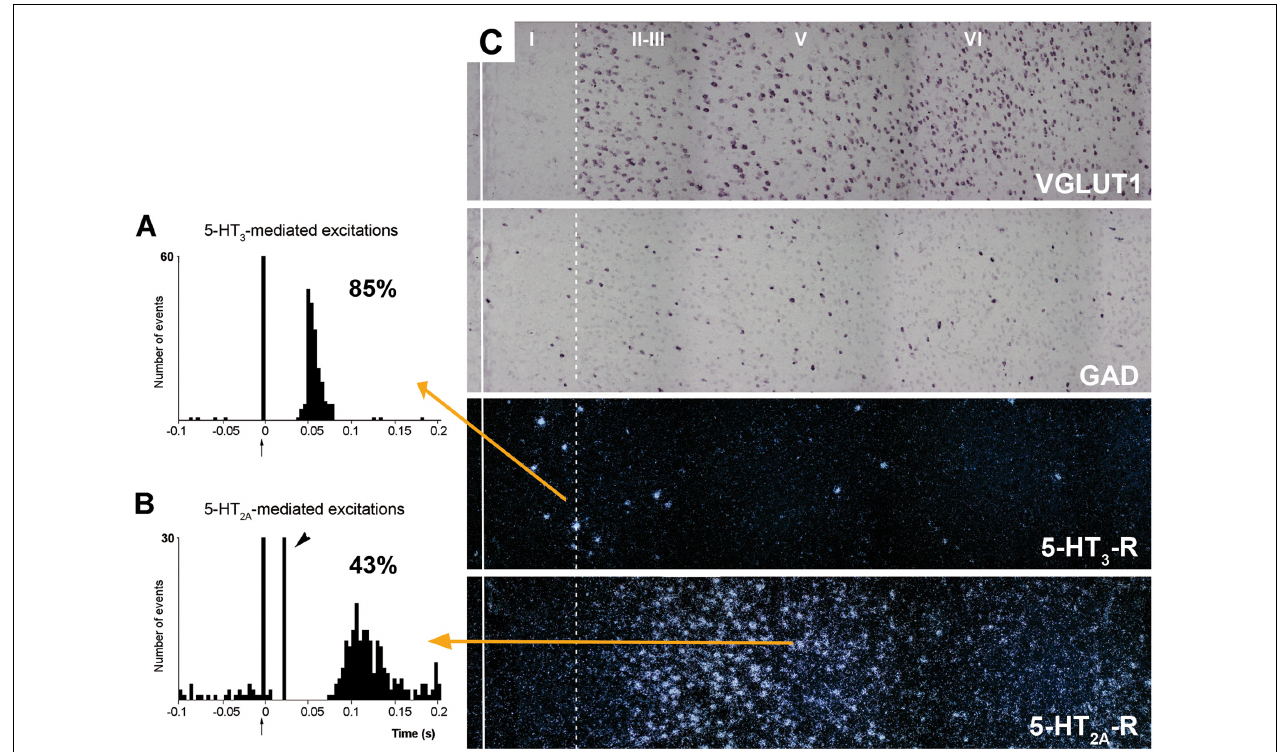
FIGURE 7 | (A,B) are peristimulus time histograms showing the orthodromic excitations elicited by the electrical stimulation of the DR at a physiological rate (0.5–1.7 mA, 0.2 ms square pulses, 0.9 Hz) on (A) a putatively GABAergic, 5-HT 3 -R-expressing neuron and (B) on a layer V pyramidal neuron in the prelimbic PFC, identified by antidromic stimulation from midbrain (note the antidromic potential, arrowhead). Both responses were selectively blocked by the administration of the respective antagonists ondansetron (A) and M100907 (B) (not shown). The 5-HT 3 -R-mediated responses in putative GABAergic neurons were faster and more effective than those evoked by 5-HT 2A -R activation in pyramidal neurons, due to the ionic nature of 5-HT 3 -R. The concordance rates of the units shown are 85% (A) and 43% (B) , i.e., 100 electric stimuli delivered in the DR evoked 80 action potentials in GABAergic interneurons through 5-HT 3 -R activation, compared to 45 action potentials evoked in layer V pyramidal neurons, mediated by the activation of 5-HT 2A -R. Each peristimulus consists of 200 triggers; bin size is 4 ms. The arrow at zero abscissa marks the stimulation artifact. (C) Composite photomicrographs showing the localization of cells expressing VGLUT1, GAD, 5-HT 3 -R, and 5-HT 2A –R mRNAs through layers I–VI at the level of the prelimbic PFC. The continuous vertical line denotes the location of the midline whereas the dotted line shows the approximate border between layers I and II. Pyramidal neurons (as visualized by VGLUT1 mRNA) are present in layers II–VI whereas GAD mRNA-positive cells are present in all layers, including layer I. Note the different location of cells expressing 5-HT 3 -R and 5-HT 2A –R. 5-HT 3 -R transcript is expressed by a limited number of GABA interneurons in layers I–III, particularly in the border between layers I and II. However, they represent 40% of GABAergic neurons in layer I. Scale bar = 150 µ m. Redrawn from Puig et al. (2004), by permission of Oxford University